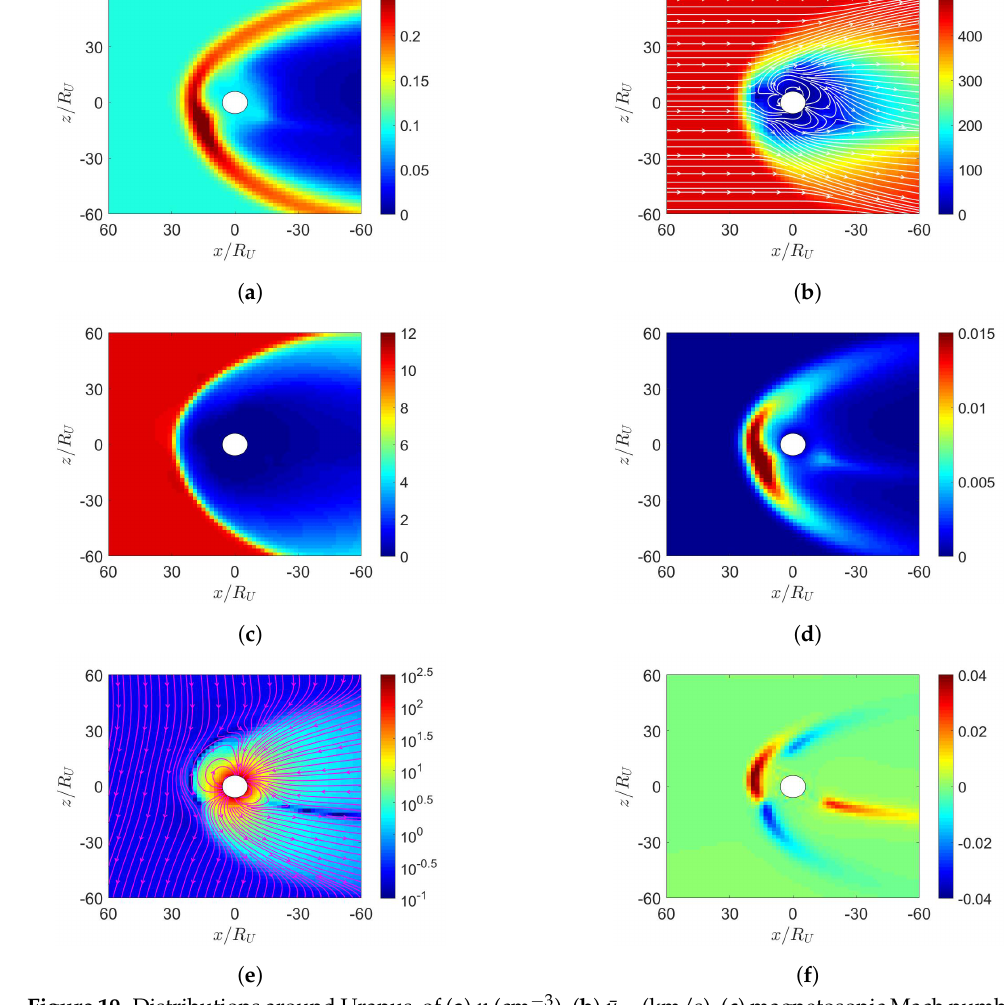
Figure 19. Distributions around Uranus of ( a ) n (cm − 3 ), ( b ) ¯ u xz (km/s), ( c ) magnetosonic Mach number, ( d ) P (nPa), ( e ) ¯ B xz (nT), ( f ) J y (nA/m 2 ); initial dipole tilts down and towards the sun, southward IMF, t = 85.4